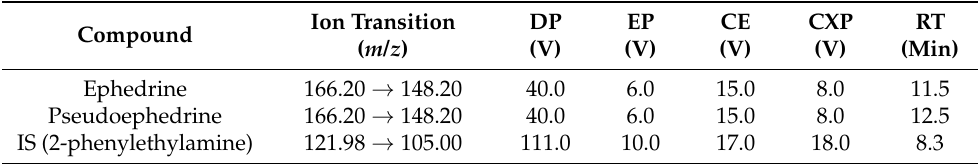
Table 5. Optimized MRM parameters and retention time for the determination of ephedrine, pseu- doephedrine, and the IS.